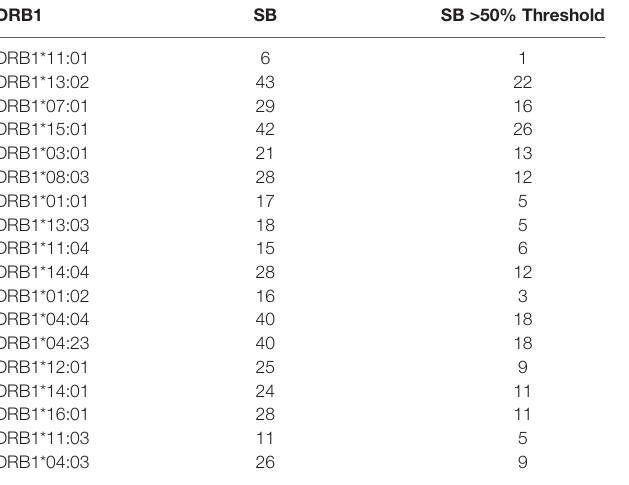
TABLE 1 | Number of strong binders for HLA DRB1 alleles identi fi ed in the enrolled vaccinees. DRB1 SB SB >50% Threshold